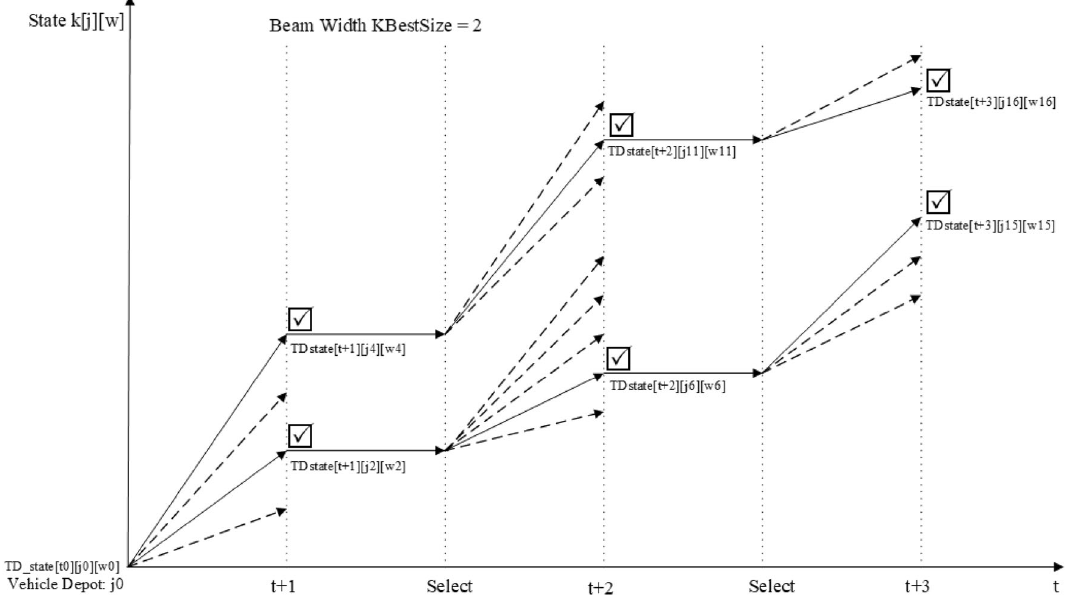
Fig. 5 The process of the time-indexed beam search algorithm, with the time dimension as the horizontal